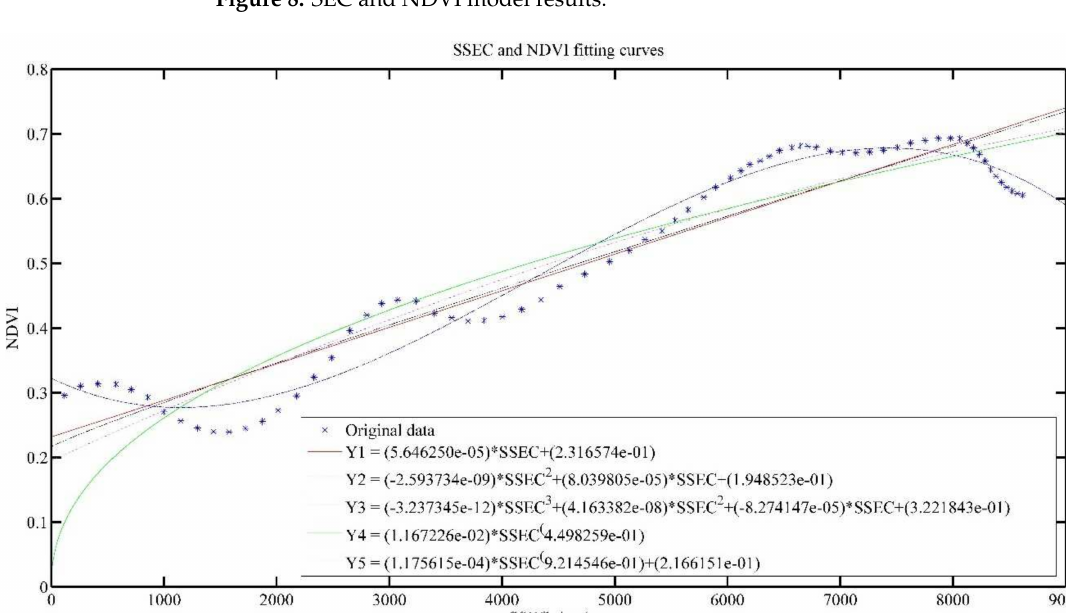
Figure 9. SSEC and NDVI model